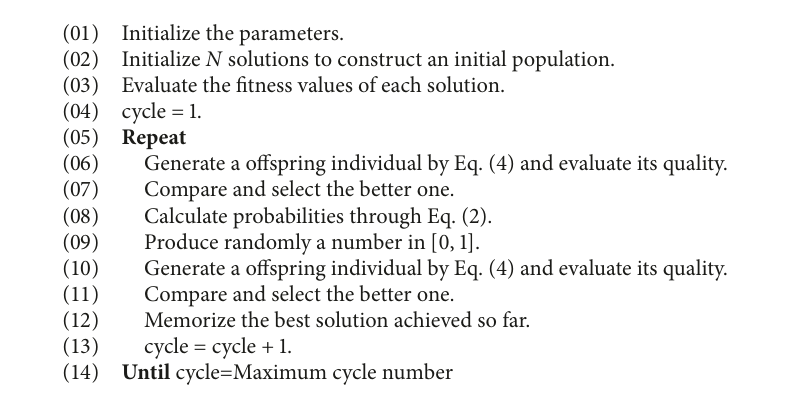
Algorithm 1: Pseudo-code of basic ABC algorithm.